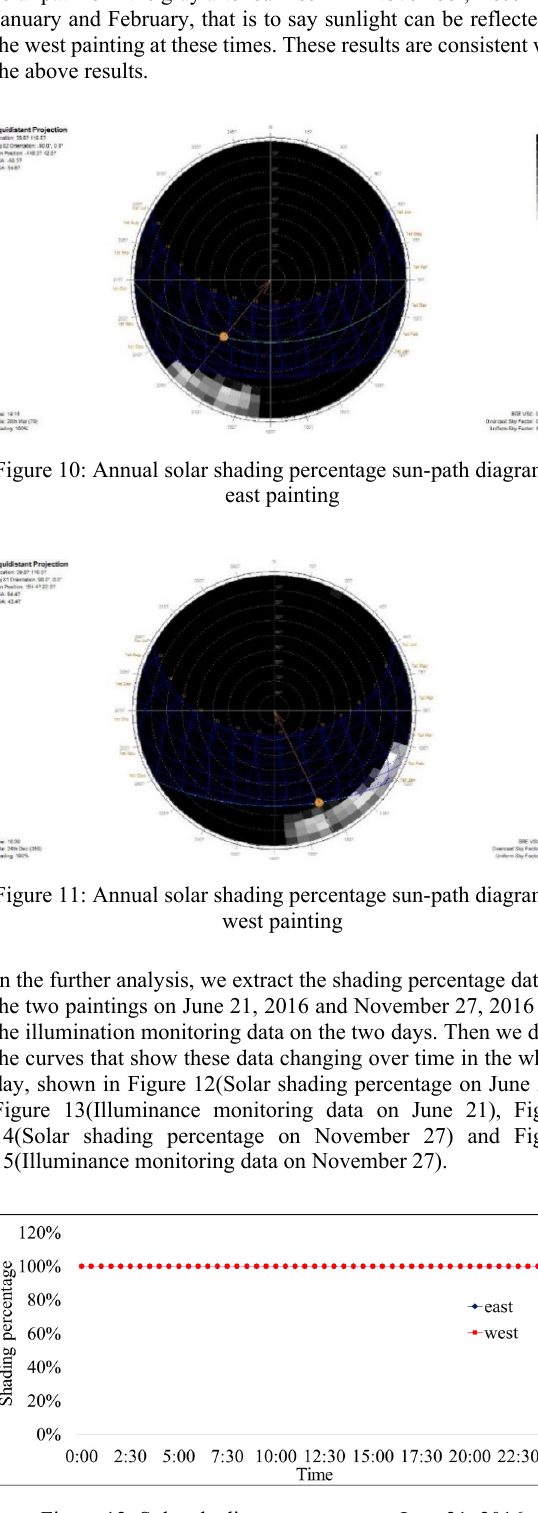
Figure 12. Solar shading percentage on June 21, 2016